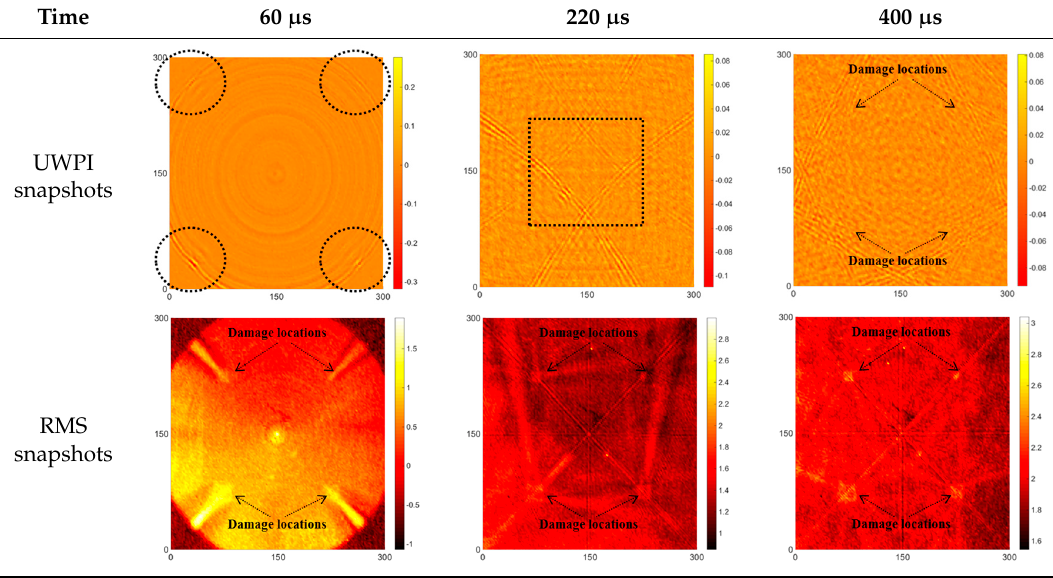
Table 9. UWPI and RMS snapshots of the back side of Specimen 2 at 60 μ s, 220 μ s and 400 μ s (the unit of x and y axis: mm).